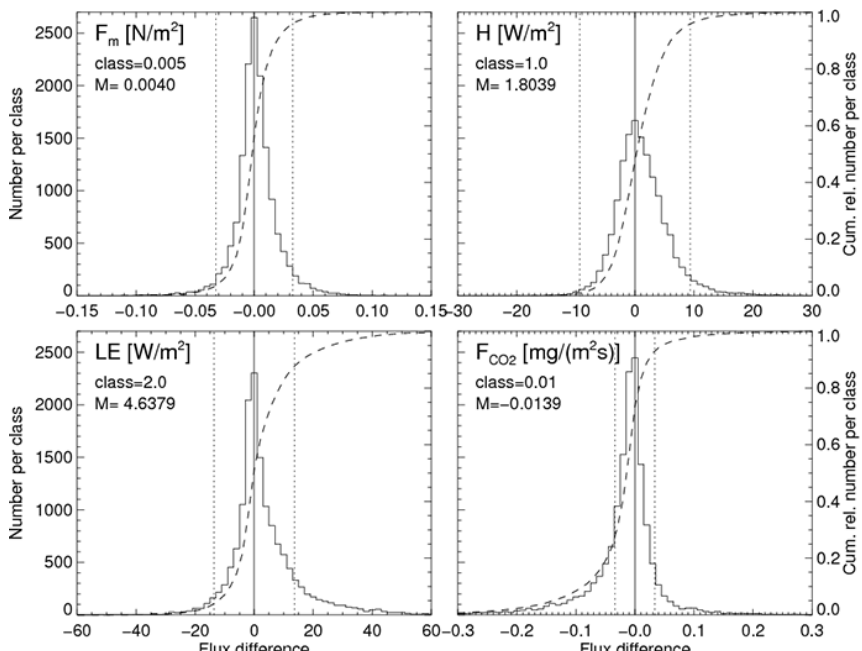
Figure 6. Distribution of flux differences (top to bottom) for momentum ( F m ), sensible ( H ) and latent heat ( LE ), and CO 2 flux (CO 2 ), based on 30min values for 1.5 years. M gives the mean difference for each; class stands for the width of class for each flux difference. The dotted lines give the measurements uncertainties, each derived from the